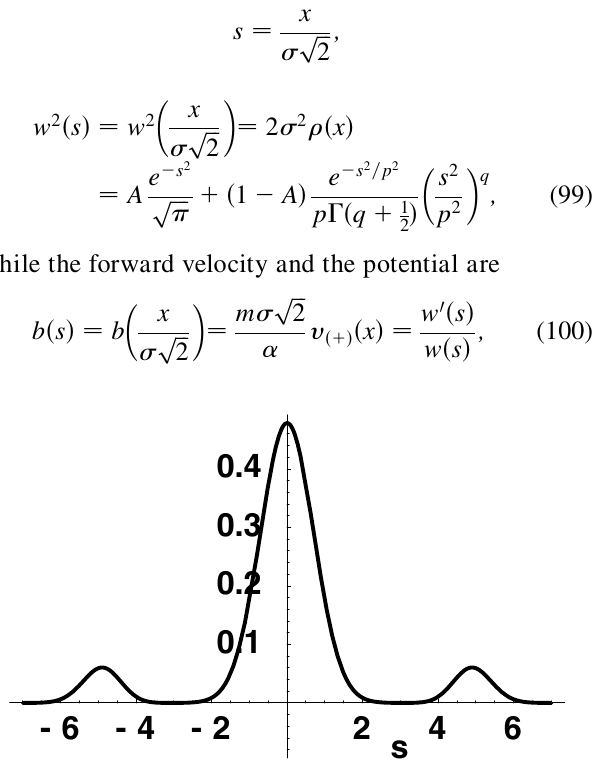
FIG. 16. The radial, dimensionless, forward velocity field for the distribution of Fig. 15 (solid line), and for the ground state of a harmonic oscillator (dashed line).